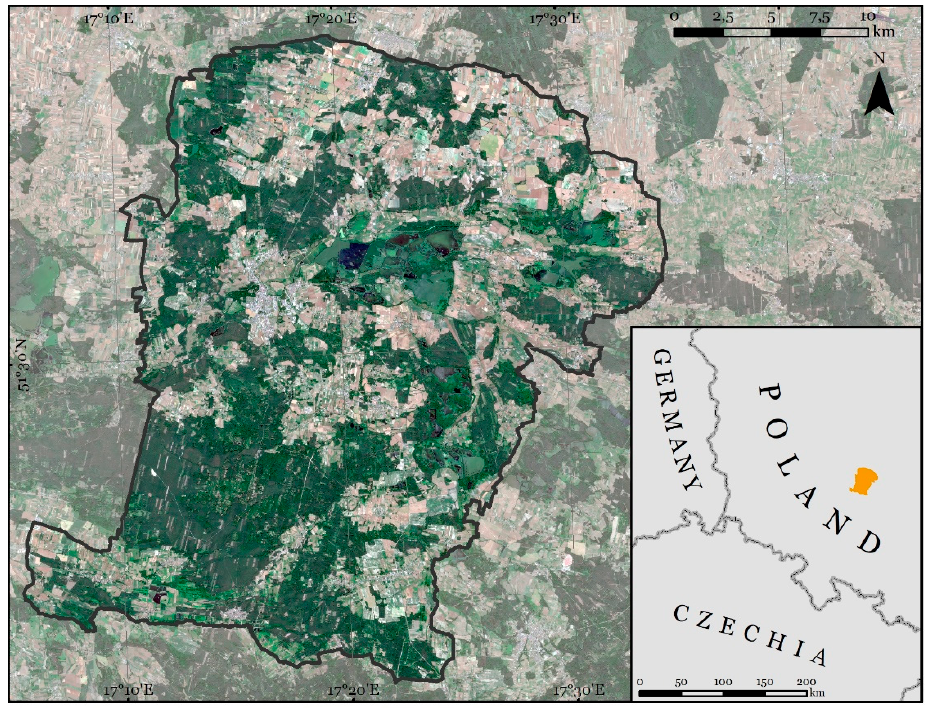
Figure 1. Study area of the Milicz Forest District located in south-western Poland. Sentinel-2 image from 30 June 2019, in natural band composition.